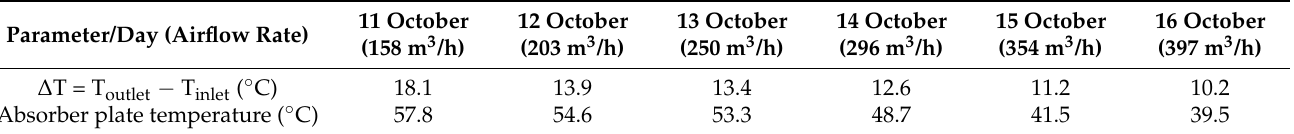
Table 4. GTC configuration: 30 mm-distance absorber—glazing. GTC thermal parameters—mean values (time interval: 13:10–14:10).